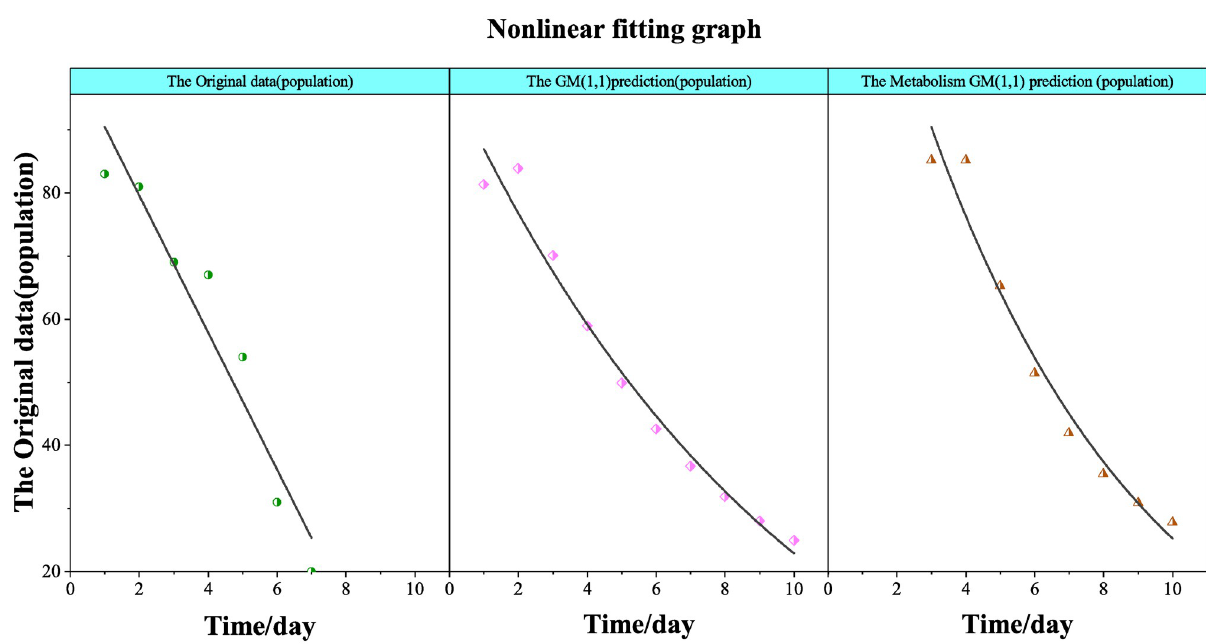
Fig 2. The nonlinear fitting